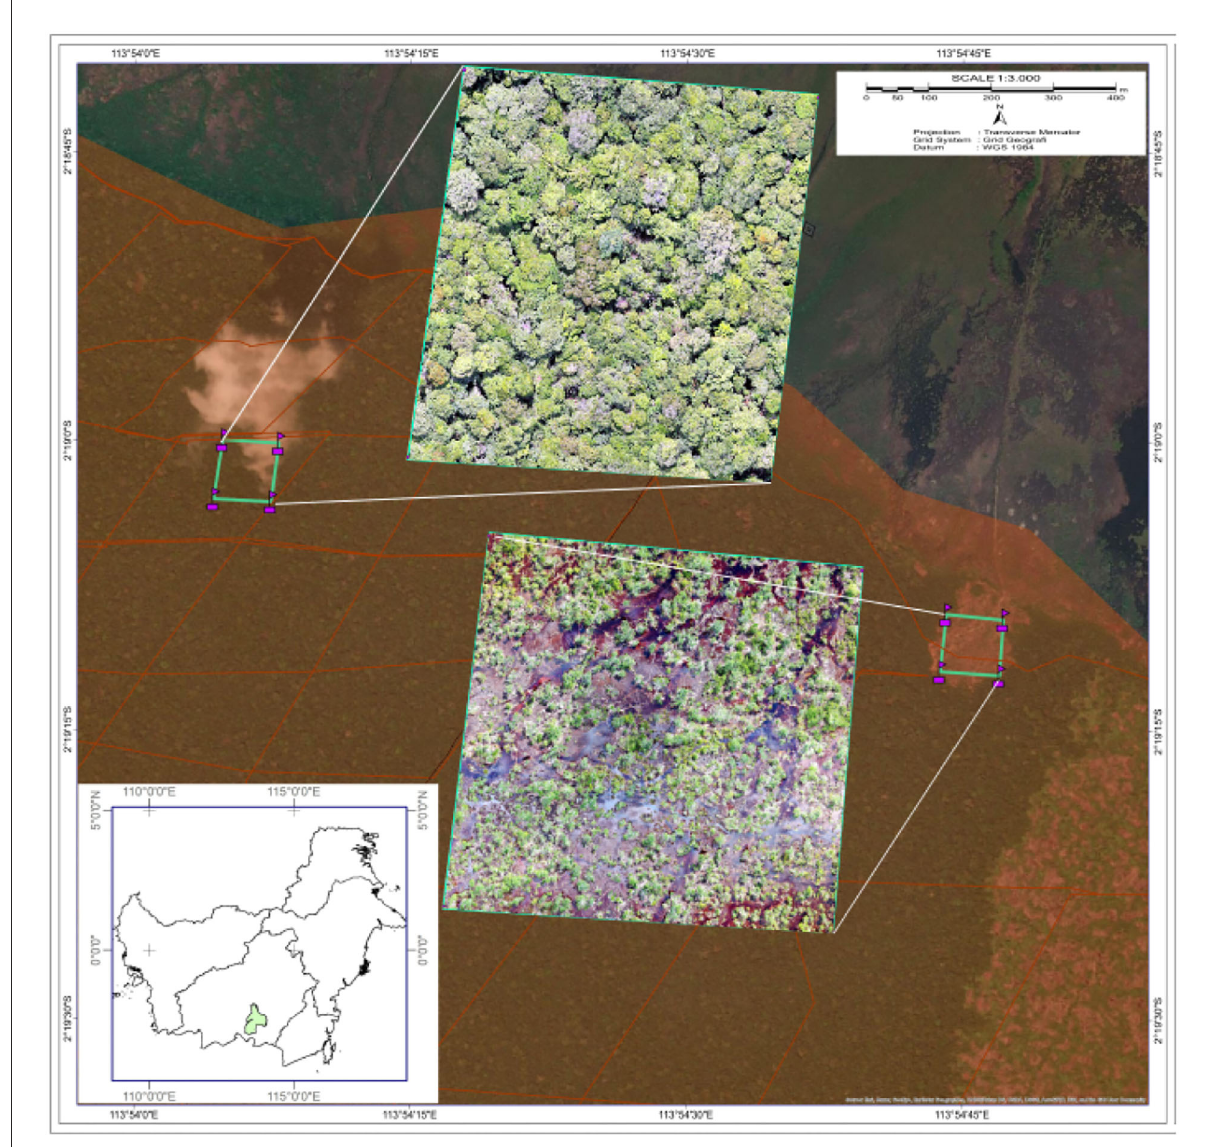
FIGURE1 Location of the study area in Sebangau, Central Kalimantan, Indonesia. The red zone in the background represents the area of Sebangau National Park, while the remaining area is the buffer of the park. The inset on the bottom left highlights the location of Sebangau National Park. Two different plots were selected for the tree survey, each sized 1 ha. Aerial drone images were taken at the unburned forest (top) and burned forest (bottom) . Source: Borneo Nature Foundation.